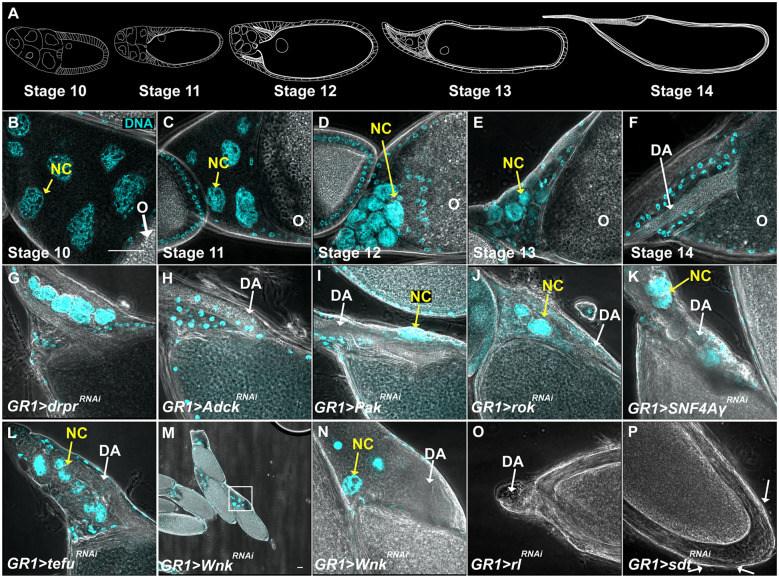
Classification of defective developmental death and clearance using the persisting nurse cell nuclei phenotype. (A) Cartoon of late stage oogenesis morphology adapted from King (1970). As egg chambers progress through the final stages of oogenesis, the volume of the NCs (anterior, left) decreases while that of the oocyte (posterior) increases. The NCs are then depleted and the oocyte development is complete with the growth of DA and a chorion shell. (B–F) Anterior (NC) region of GR1>LucRNAi (control) egg chambers during the final stages of oogenesis. DNA is labeled with DAPI (cyan). NC nuclei are indicated by yellow arrows, and small nuclei are FCs. (B) At stage 10, NC chromatin is dispersed and the nuclei are surrounded by cytoplasm. (C) During stage 11, NCs dump their cytoplasmic contents into the oocyte (O). (D and E) By stage 12, dumping is complete and throughout stages 12 and 13, the NC nuclei are cleared. (F) By stage 14, all nuclei are cleared and the oocyte has fully developed DA. (G–O) Representative images of anterior regions of stage 14 egg chambers demonstrating different developmental death and clearance phenotypes. DNA labeled with DAPI (cyan). (G) A stage 14 egg chamber from GR1>drprRNAi fly demonstrates a very strong PN phenotype. (H) GR1>AdckHMS02533 demonstrates no PN phenotype. (I) GR1>PakHM05156 demonstrates a mild PN phenotype. (J) GR1>rokJF03225 demonstrates a moderate PN phenotype. (K) GR1>SNF4AgammaJF02060 demonstrates a strong PN phenotype. (L) GR1>tefuHMS02790 demonstrates a very strong phenotype. (M and N) GR1>WnkHMJ02087 demonstrates a dumpless phenotype. (M) Several GR1>WnkHMJ02087 egg chambers shown at 100X. (N) A 600X image of square in box M. (O) GR1>rlHMS00173 demonstrates a gnarled dorsal appendage phenotype. (P) GR1>sdtHMS00953 demonstrates a “bumpy” chorion phenotype (white arrows). All scale bars depict 50 μm. Scale bar in B is representative of all images in this figure unless otherwise indicated.